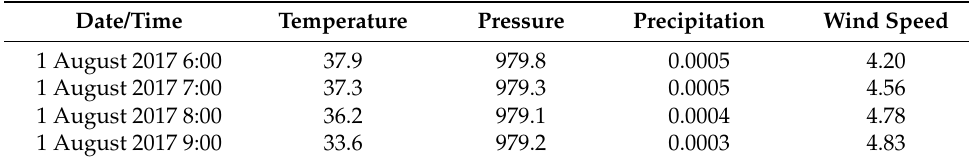
Table 2. Examples of weather-condition